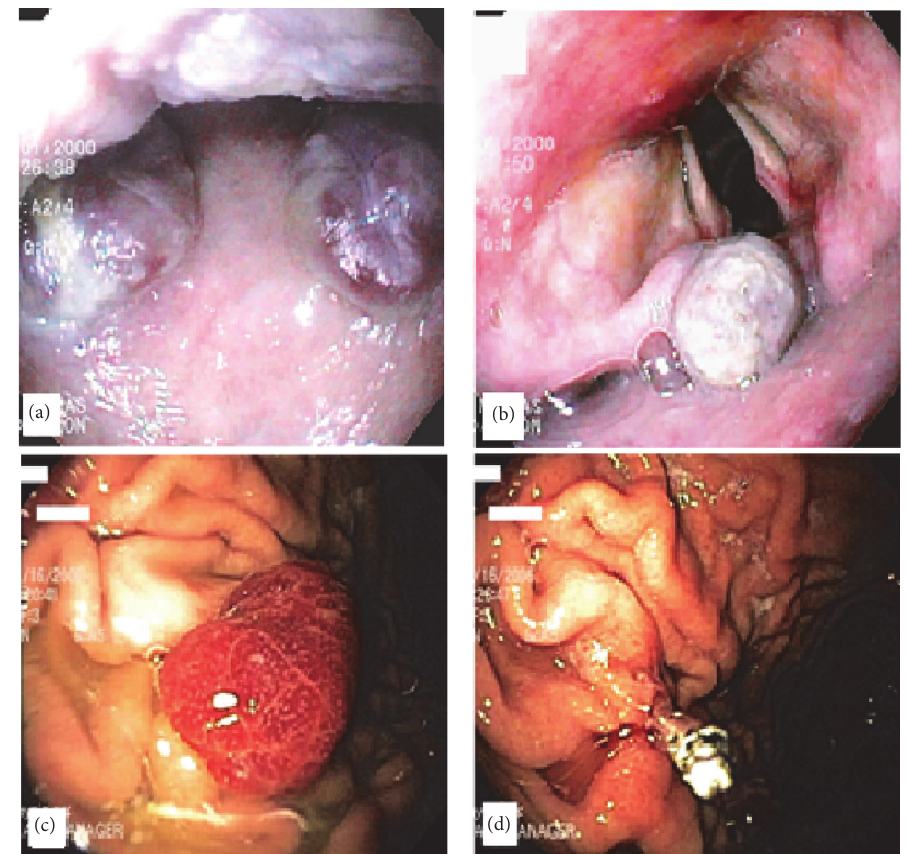
Figure 1: (a) Two hypervascularized violaceous submucosal nodules on soft palate; (b) one submucosal nodule in the oropharynx on the epiglottis near the vocal cords; (c) hypervascularized reddish polyp in the gastric fundus with size of 10mm; (d) endoclip was placed at postpolypectomy site after removal from polyp seen in image